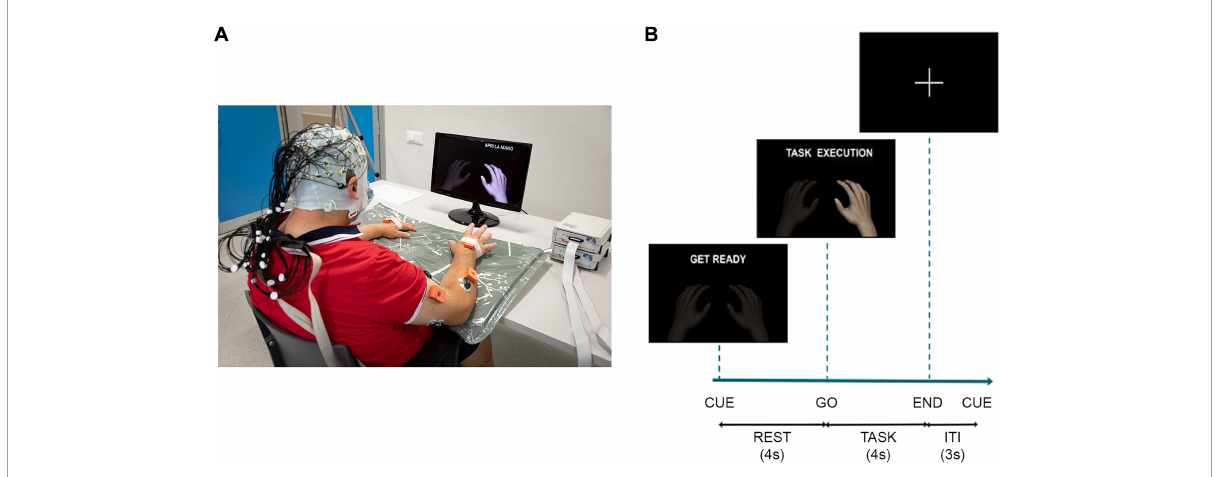
FIGURE1 (A) Schematic of the experimental setup: participants wore an EEG cap over the scalp and EMG sensors over the upper limbs, they watched a screen placed 1 m in front of them on which a cue provided information on when to perform/attempt the movement. In addition to EEG and EMG data, the recording included also kinematic data. They were collected at 100 Hz by means of 8 IMUs (MTw Awinda, Xsens Technologies, The Netherlands). The IMUs were placed by a double-sided medical tape on the following anatomical points: hand, mid forearm, mid arm of both upper limbs, over the clavicular notch and at the lumbar vertebrae level. The participant signed a written informed consent to the collection and use of his images. (B) Timeline of the experiment for task trials with the instructions provided to the participants on the screen, ITI,